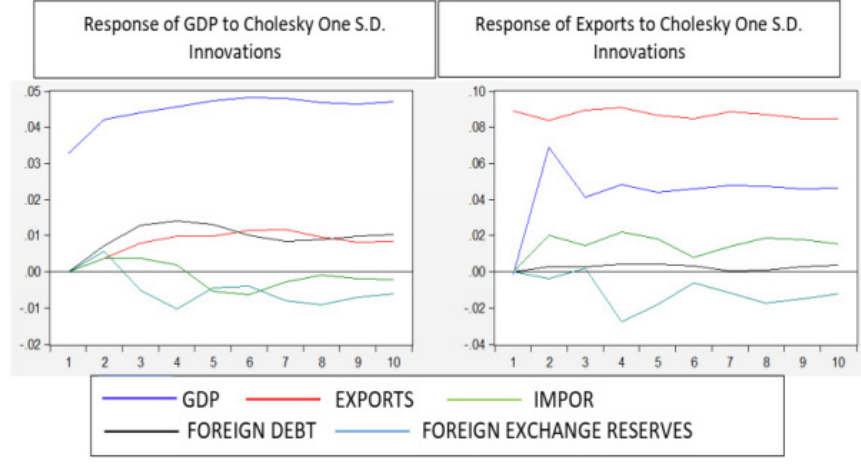
Figure 2: IRF Graphics of Response GDP and